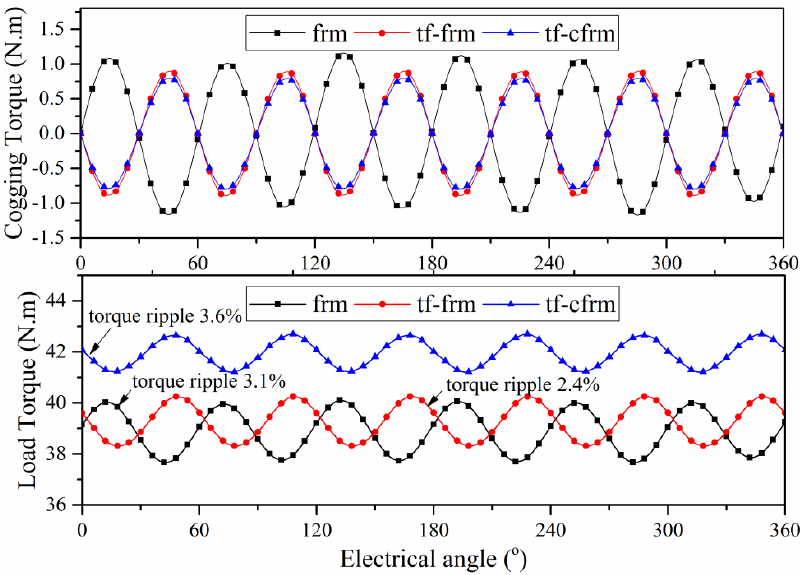
Figure 8. Torque performance comparison between FRM, TF-FRM, and TF-CFRM by 3D FEM. Table 2. Torque density comparison of TF-CFRM, TF-FRM, TFPM, and FRM.